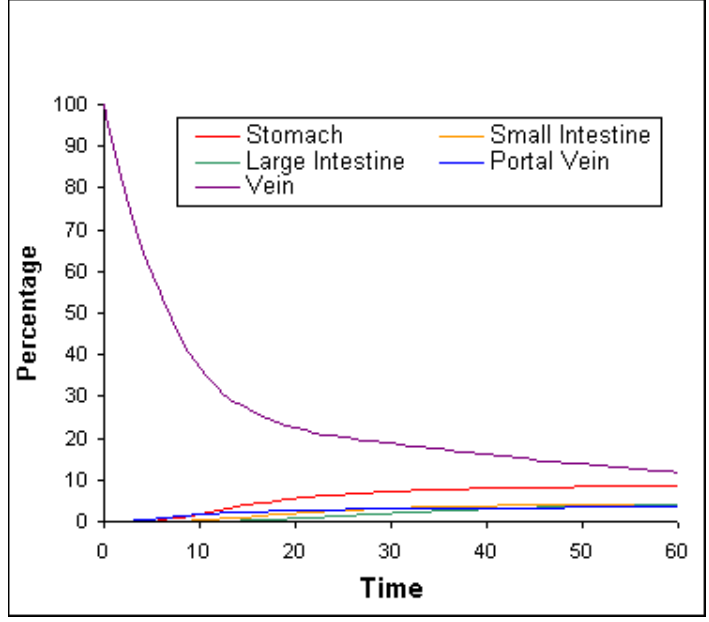
FIGURE 8 . Simulation of an intravenous dose when provision is made for exsorption from the portal vein to the stomach. Drug then appears in the stomach and other parts of the gastrointestinal tract.